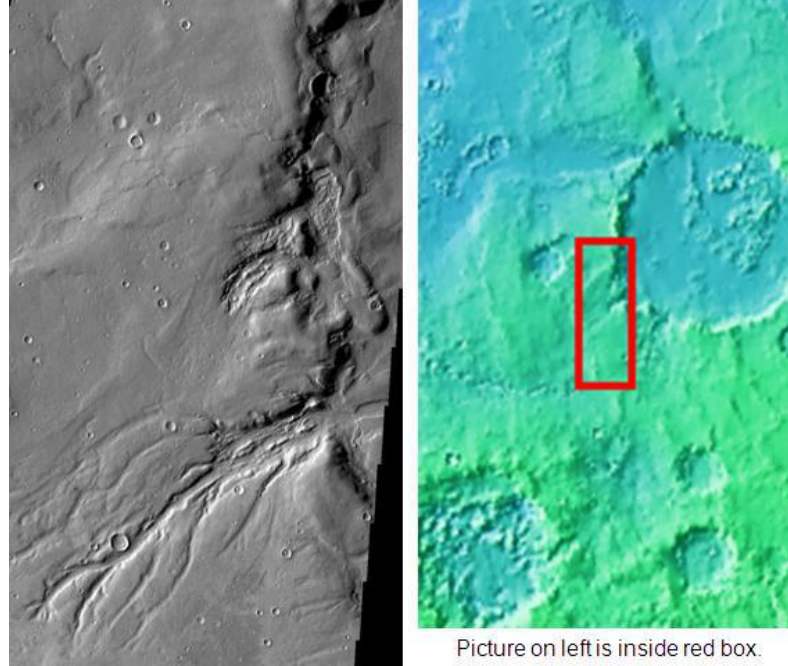
Figure 17. The complex drainage system in Semeykin Crater. Location is the Ismenius Lacus Figure17. ThecomplexdrainagesysteminSemeykinCrater. quadrangle.